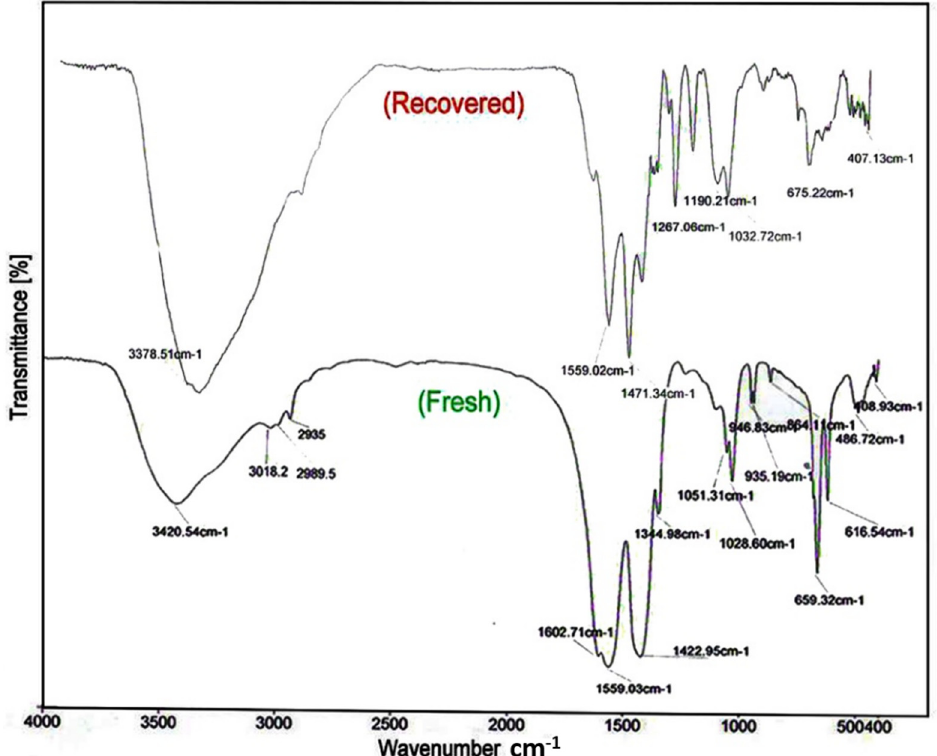
Figure 10. FT-IR spectra of fresh and recovered Mn-supported nano-catalysts.